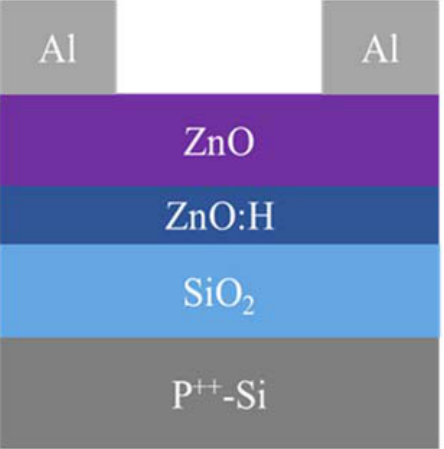
Figure 1. The device structure of bottom ‐ gate top ‐ contact ZnO:H/ZnO ‐ TFT.